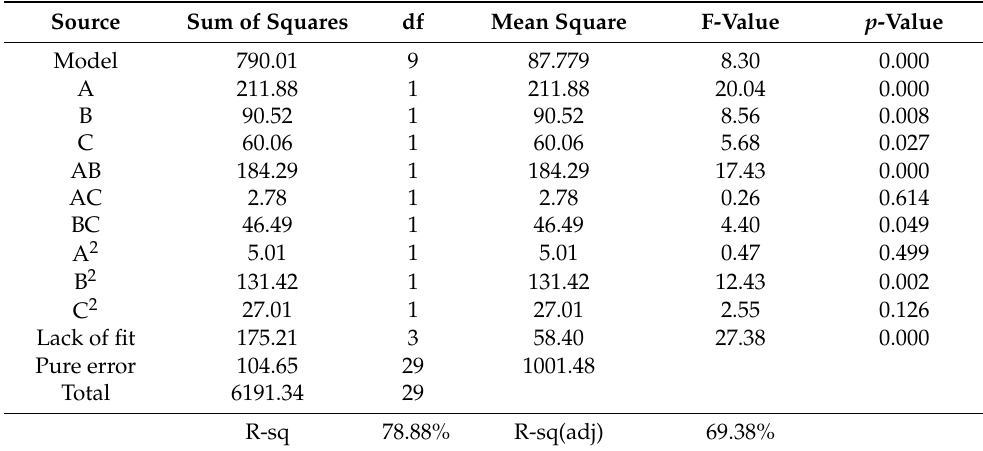
Table 6. Results of ANOVA performed on the elongation